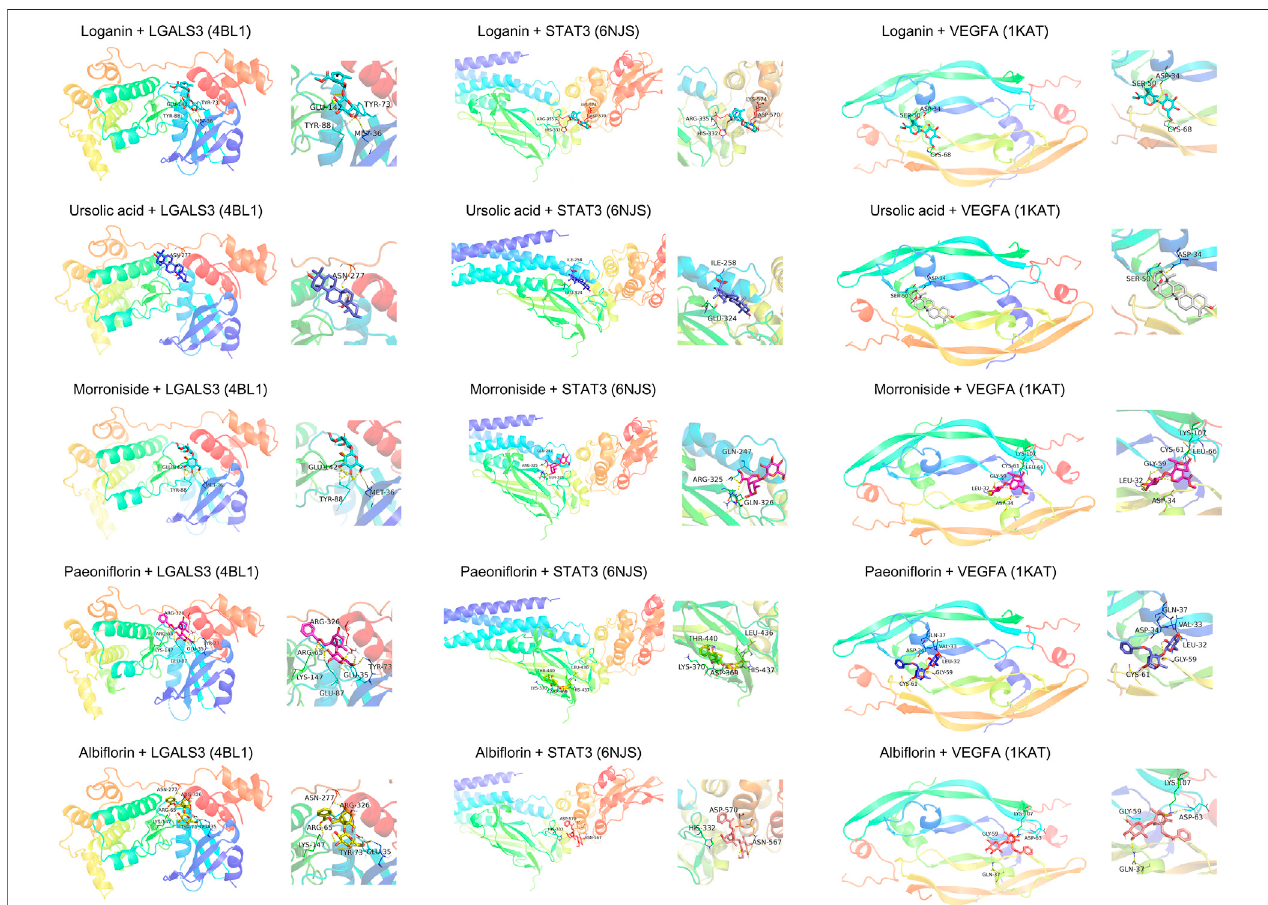
FIGURE 7 | Molecular docking simulation of compound-target binding. Using AutoDock Vina, molecular docking analysis was performed between the fi ve active compounds and three selected targets among the eight identi fi ed: LGALS3, STAT3, and VEGFA. The PDB IDs of the receptor proteins ofLGALS3, STAT3, and VEGFA are 4BL1, 6NJS, and 1KAT, respectively.The three targets were able tospontaneously bind toeach ofthe fi ve active compounds via forces such ashydrogen bonds to form a stable conformation.